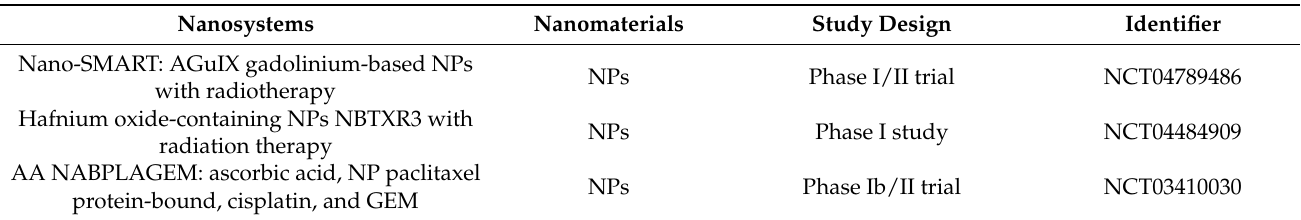
Figure 1. Well-designed nanosystems for different PDAC therapeutics. Created using BioRender.com. Table 1. Clinical trials of nanosystem therapeutic strategies for PDAC (obtained from https://clinicaltrials.gov/, accessed on 1 October 2022).